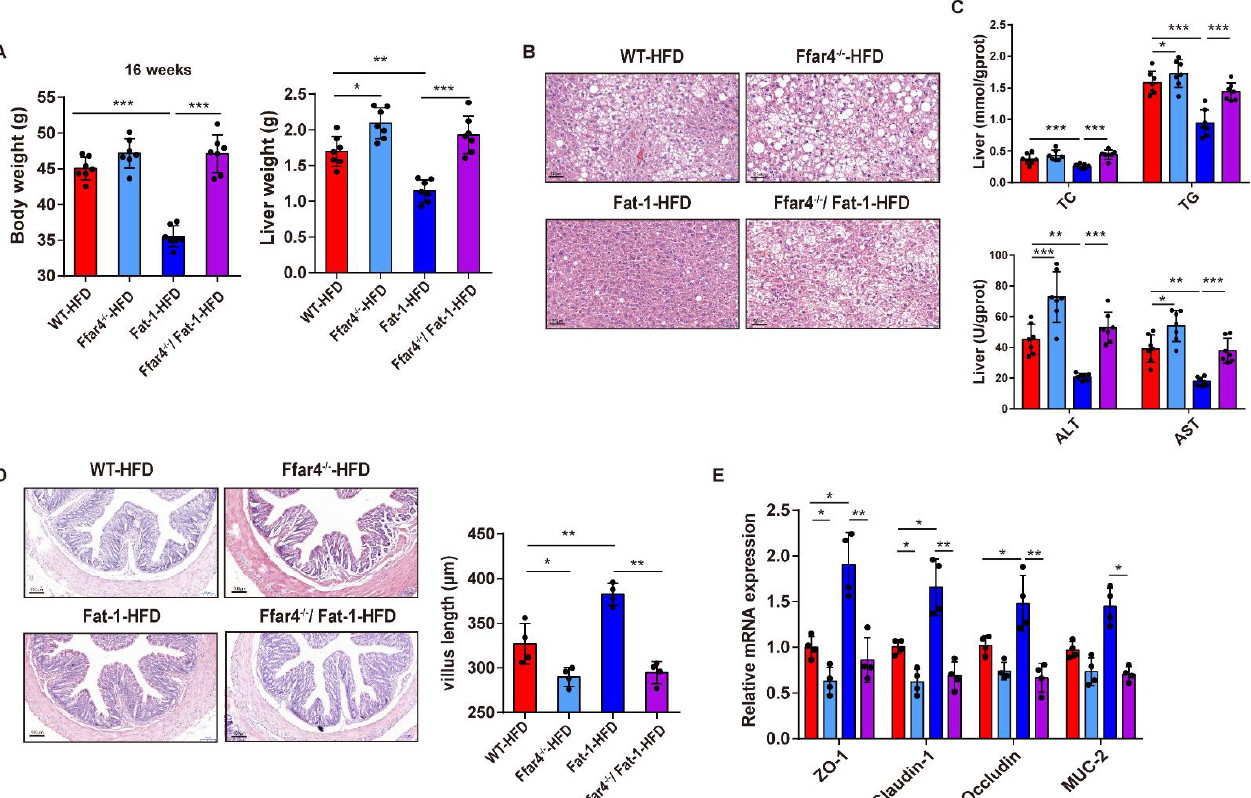
Figure 2. FFAR4 deficiency blocks the beneficial effects of endogenous n -3 PUFA. ( A ) Final body weight and liver weight at 16 weeks. ( B ) Liver pathology of different groups (200× magnification; scale bar = 50 μm). ( C ) Hepatic TC, TG, ALT, and AST content. ( D ) Representative images of H&E- stained colon sections (100× magnification; scale bar = 100 μm). Villus length quantified using ImageJ software (right). ( E ) Intestinal barrier function genes analyzed with qPCR. Results are presented as mean ± SD ( n = 7, per group). * p < 0.05, ** p < 0.01, and *** p < 0.001.